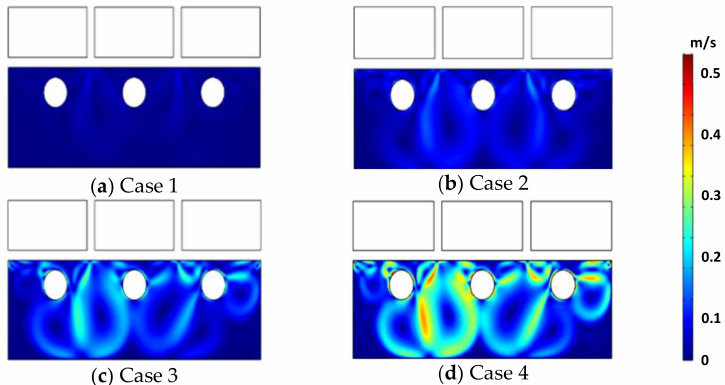
Figure 8. Velocity contours in the case of three permanent magnets (Case C).